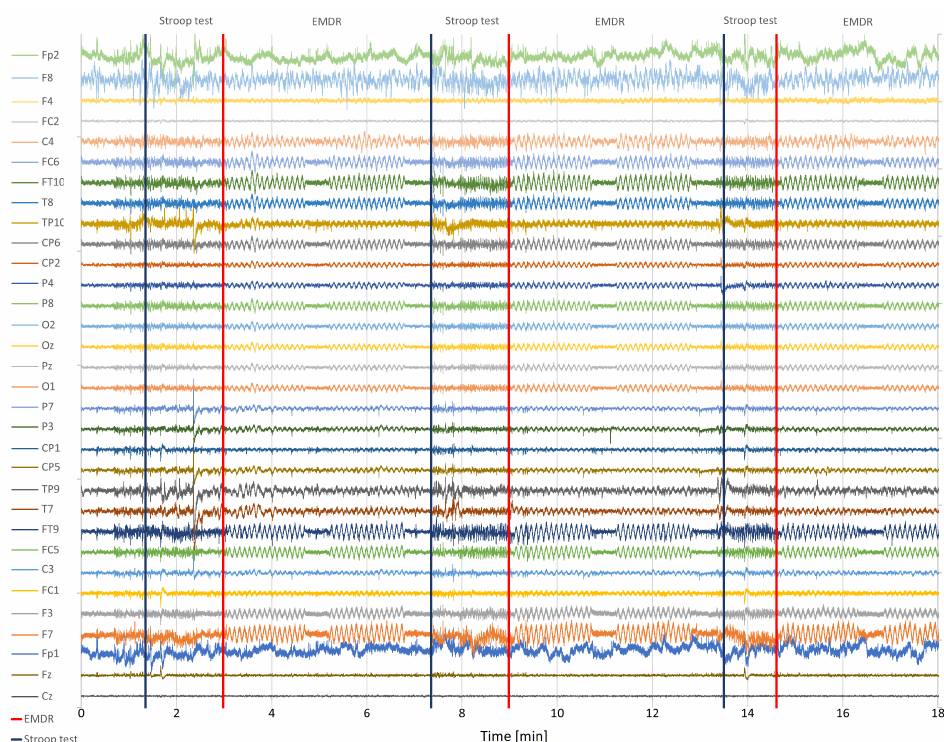
Figure 7. Signals recorded for a sample participant (RAW